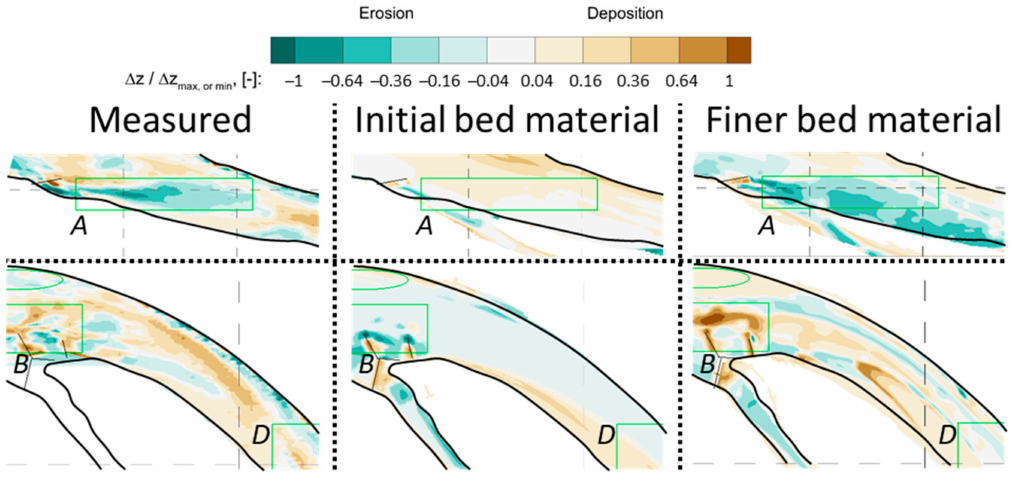
Figure 14. Calculated bed changes by the combining method for the historical flood wave. The model in the middle figure was set up with the initial, while in the right figure with finer bed